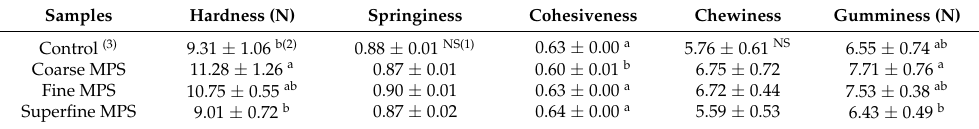
Table 4. The quality characteristics of sponge cake prepared with differently sized MP.